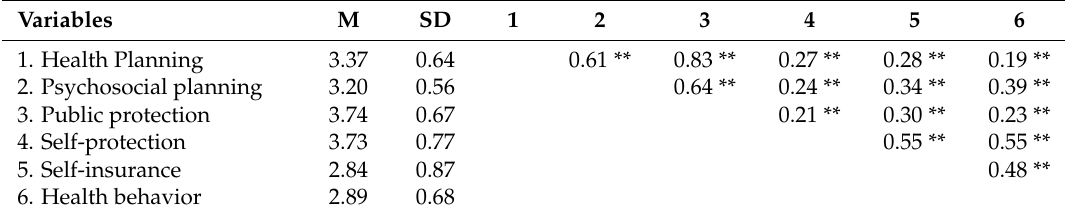
Table 2. Descriptive statistics and correlation